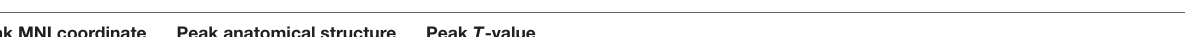
FIGURE 3 | VBM results. Regions with negative correlation with the age are shown in the upper row (blue), those with positive correlation with DR score without age as a covariate are shown in the middle row (yellow) and the overlapped regions between the two are shown in the bottom row (green) (FWE p < 0.05). TABLE 5 | Anatomical structures correlated with age in